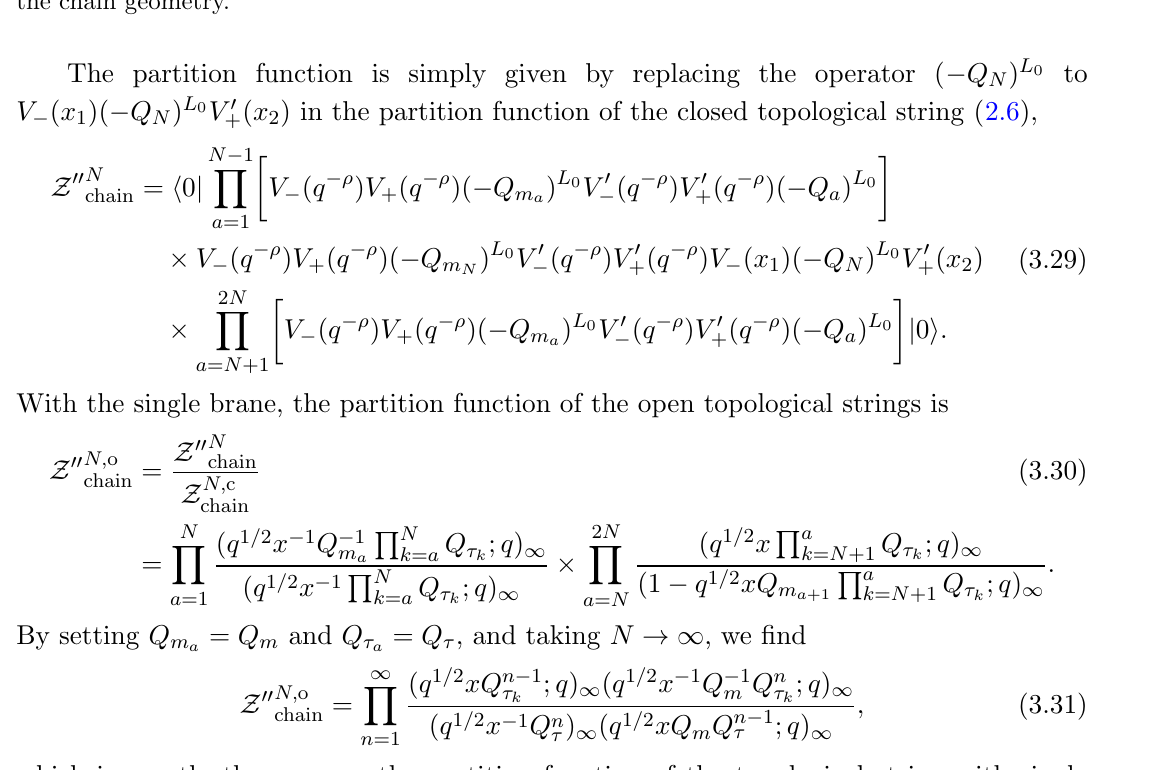
Figure 8 . The 2 N -chain geometry with the inner branes. The branes are located at the middle of the chain